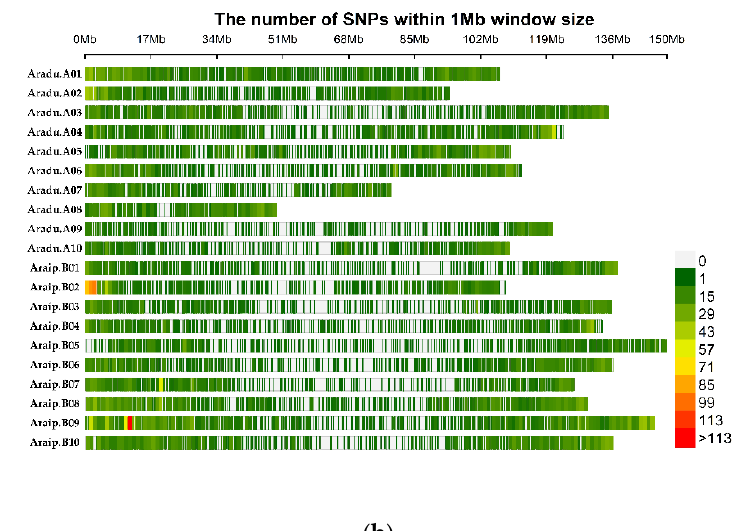
Figure 1. Single nucleotide polymorphisms (SNP) distribution in the 20 chromosomes of the culti- vated peanut. The horizontal axis shows the chromosome length (Mb); the shades of red represent SNP density. The vertical axis shows the 20 chromosomes. ( a ) Polymorphic SNPs (except for scaffold markers); ( b ) Polymorphic SNPs (except for scaffold markers) after filtering by GAPIT coding.